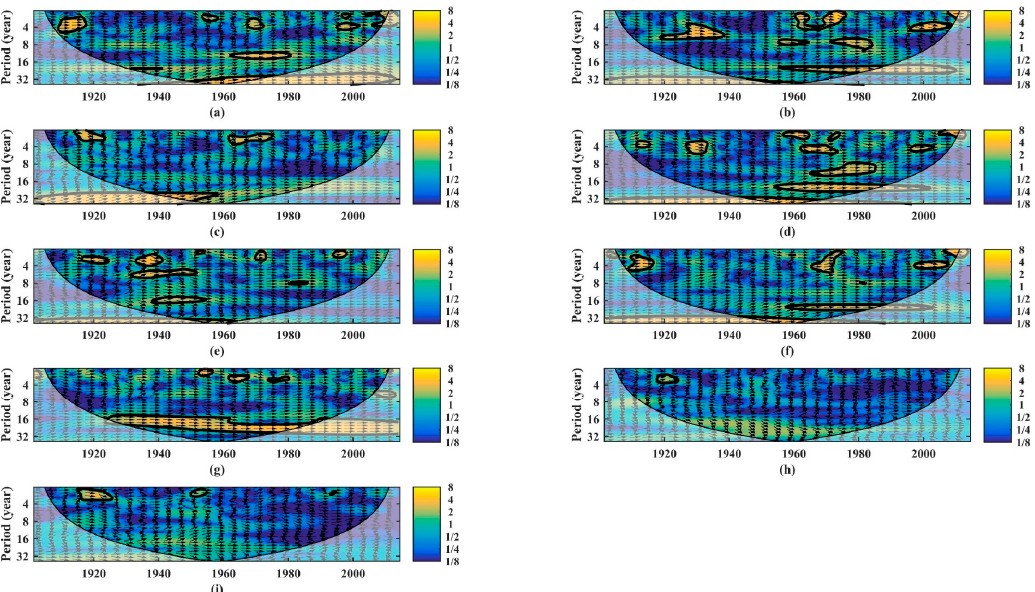
Figure 5. Cross-wavelet analysis results between the SPI and SRI of river basins SLRB ( a ), HARB ( b ), YRB ( c ), HURB ( d ), YARB ( e ), SEB ( f ), PRB ( g ), and SWB ( h ), and CB ( i ). The thick contours denoting a 95% confidence level are shown as yellow fill surrounded by a black outline. The relative phase relationship is presented as arrows (with anti-phase toward the left and in-phase toward the right). The color bar to the right of the diagram denotes the wavelet energy. (For interpretation of the references to color in this figure legend, the reader is referred to the Web version of this article.).